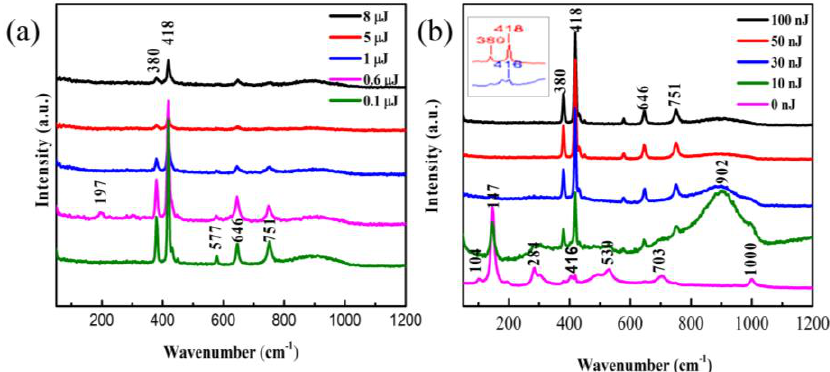
Figure 6. Raman spectra of V 2 O 5 irradiated by high pulse energy ( a ) and low pulse energy ( b ). Inset shows the slightly shift of the peak at 416 cm − 1